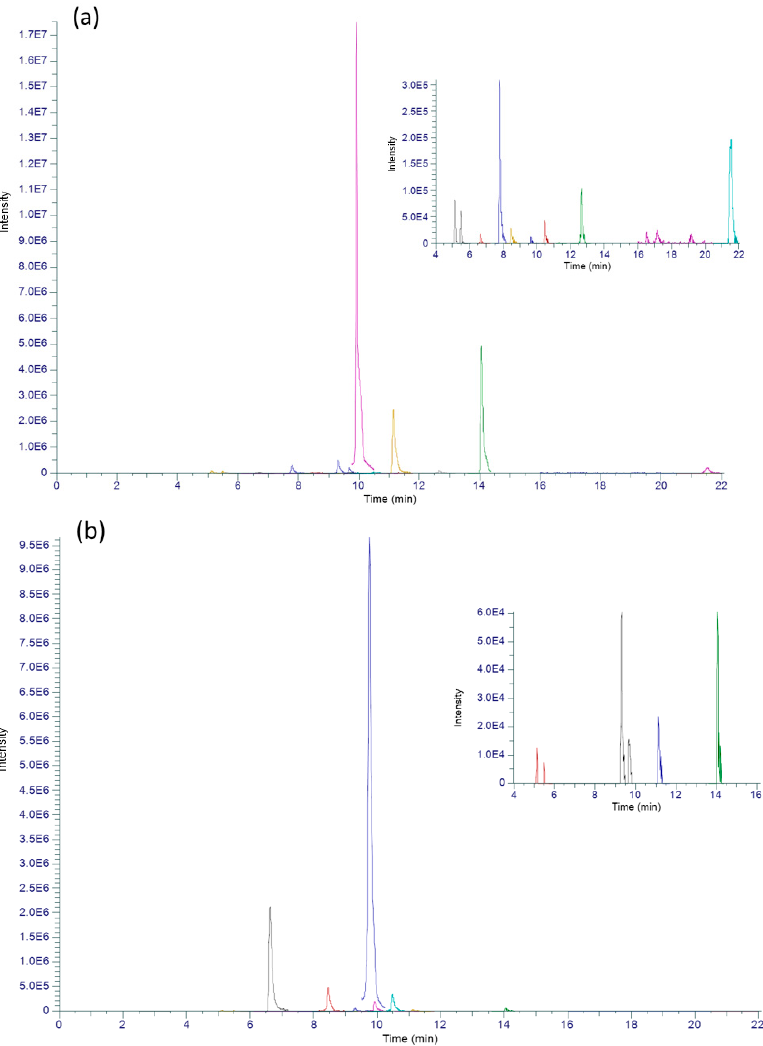
Figure 3. LC-MS example chromatograms obtained for ( a ) hospital and ( b ) bird slaughterhouse samples.